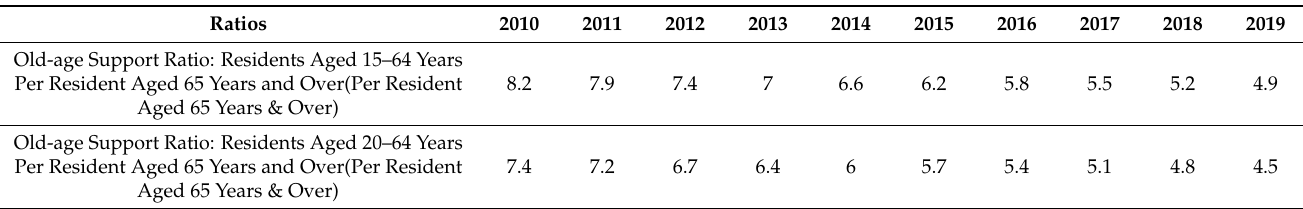
Table 7. Old-age support ratio: residents aged 15–64 and 20–64 years per resident aged 65 years and over (per resident aged 65 years and